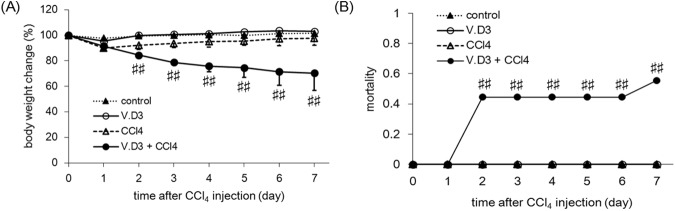
Effect of pre-treatment with V.D3 on CCl4 toxicity, as assessed by body weight change and mortality.Mice were treated as described in legend for Fig 2. Body weights (normalized to baseline) (A) and mortality (B) were recorded every 24 h through the 7th day after CCl4 injection. Data are presented as mean ± S.D. of 4–9 mice. ##
P < 0.01 versus CCl4 group on the respective day.